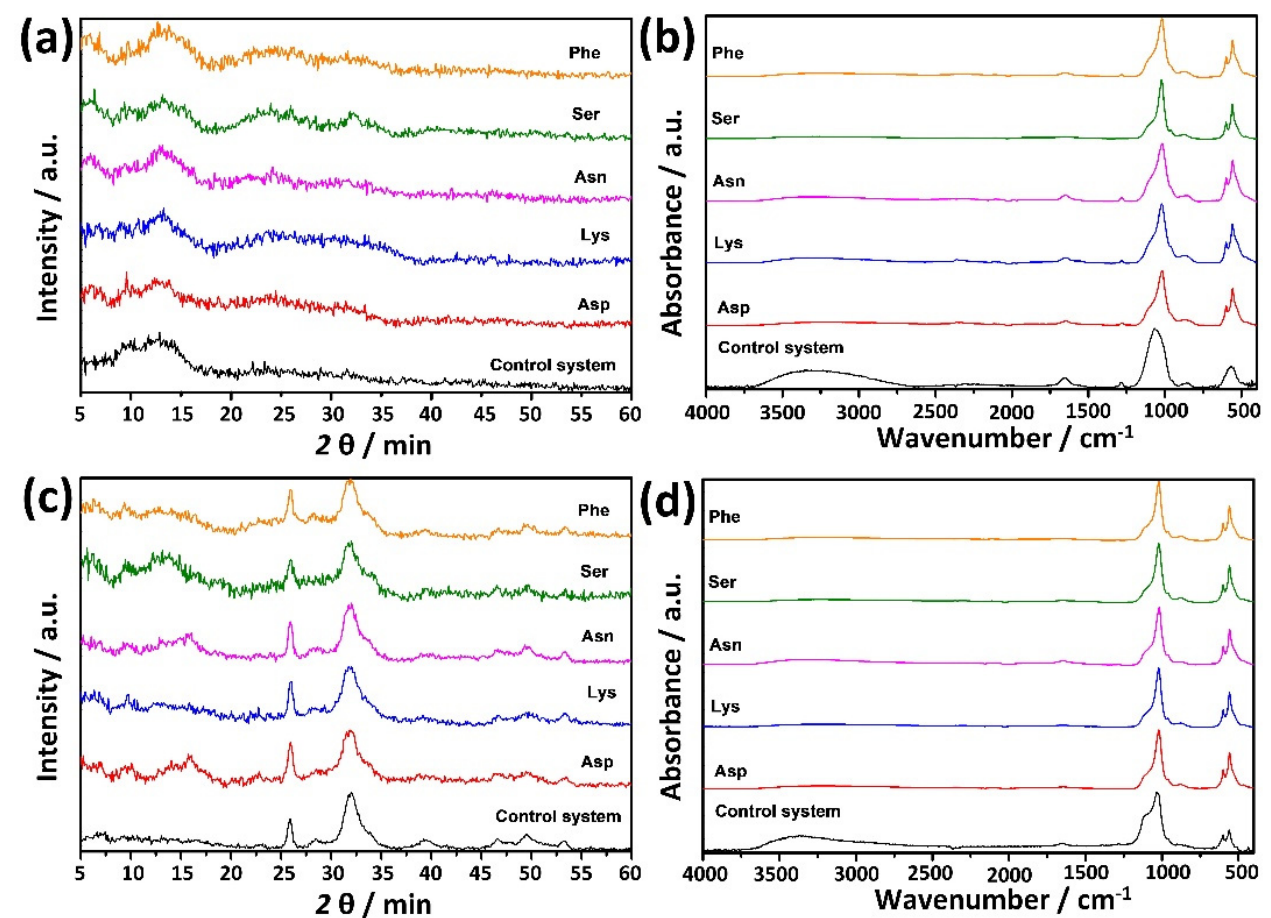
Figure 2. PXRD diffractograms ( a , c ) and FTIR spectra ( b , d ) of the precipitates obtained in the control system (CS) and systems containing 5 mmol dm − 3 AAs after ( a , b ) 10 min and ( c , d ) 60 min reaction time (60 and 150 min in the case of Ser). c (CaCl 2 · 2H 2 O) = c (Na 2 HPO 4 ) = 5 mmol dm − 3 , c (NaCl) = 0.15 mol dm − 3 , pH initial = 7.4, ϑ = (25.0 ± 0.1) ◦ C, magnetic stirring. Asp—aspartic acid, Lys—lysine, Asn— asparagine, Ser—serine, Phe—phenylalanine.